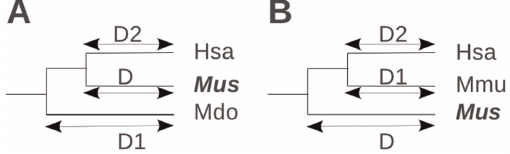
Figure 3. Test used at protein level to conclude on putative gene or putative pseudogene. The species where the protein is tested is highlighted in bold type. Other species have known proteins. D1 and D2 are age of divergence, in millions of years. Note that all abbreviations concerning species name and their ancestors are provided in Figure 6 (A) The species in which the protein is